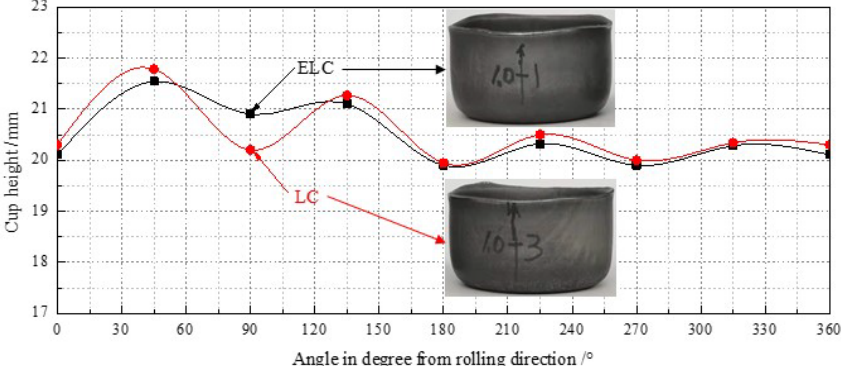
14 of 20 Figure 14. Dislocation structure of different C content: ( a ) ELC; ( b ) LC. The sheet metal formability is mainly tested by earing test, Hole expanding test and V-shaped bending test. It is considered [34] that the long yield platform is prone to wrin- kles on the steel surface in the process of stamping or bending deformation, which affects